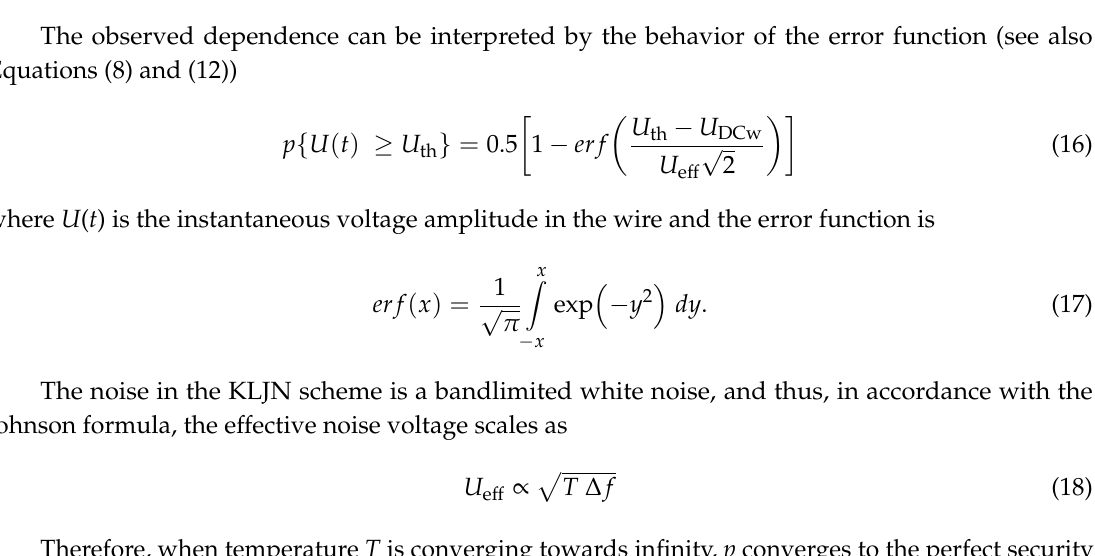
Figure 4. Eve’s correct guessing probability ( p) of key bits versus temperatures at bandwidth ∆ f equals 10 6 Hz, for key length 700 bits, and duration/bit (number of samples/bit) 200, 500, and 1000, respectively. The limit p = 0.5 stands for perfect security.